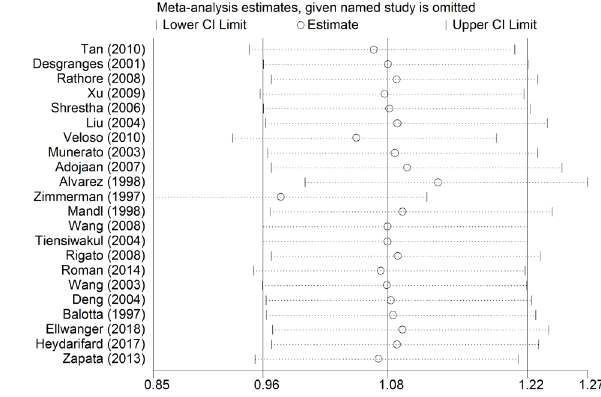
Figure 4: Sensitivity analysis for the influences of CCR5-delta32 polymorphism and HIV-1 infection susceptibility under the allele